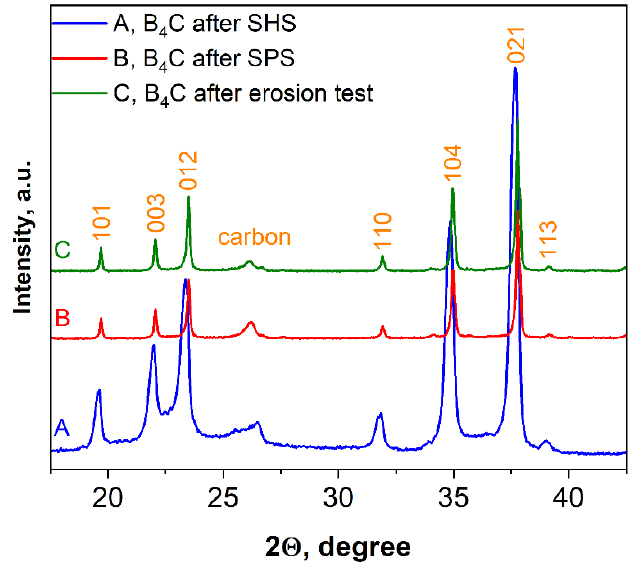
Figure 10. XRD patterns of boron carbide, sample 5.